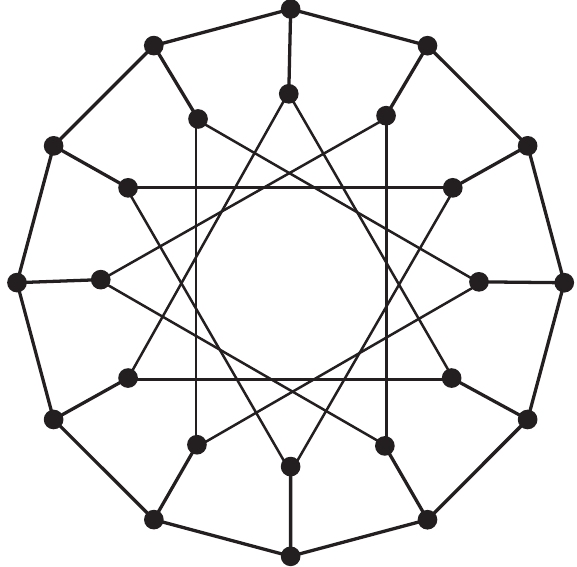
Figure 1: Generalized Petersen graph P